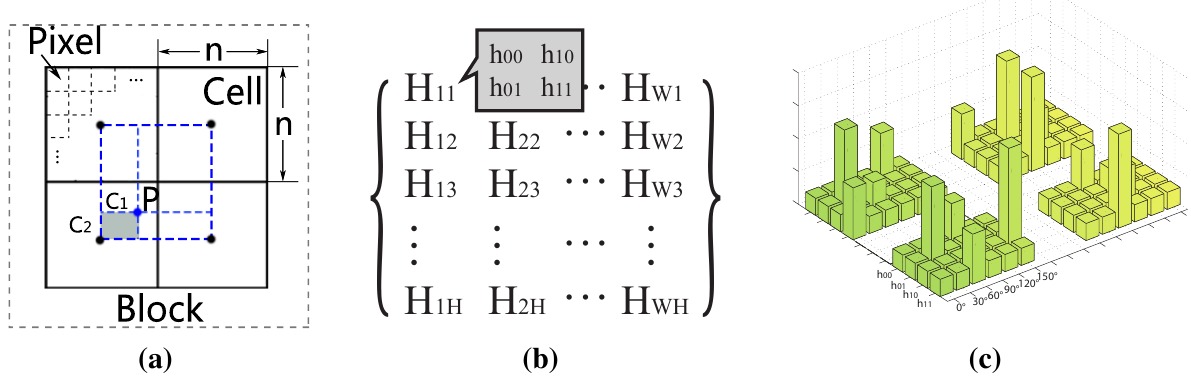
Figure 8. Deformation tolerance scheme: ( a ) structure-context descriptor. Each block has 2 × 2 cells, and each cell has n × n pixels, the set of which has 16 empirically in our work; ( b ) matrix of the histograms for the feature map; W and H in subscripts represent the width and height of the input image, respectively; ( c ) 3D model to present part of the feature map in (b). Each 4 d × 6 bin histogram corresponds to a point in vector A